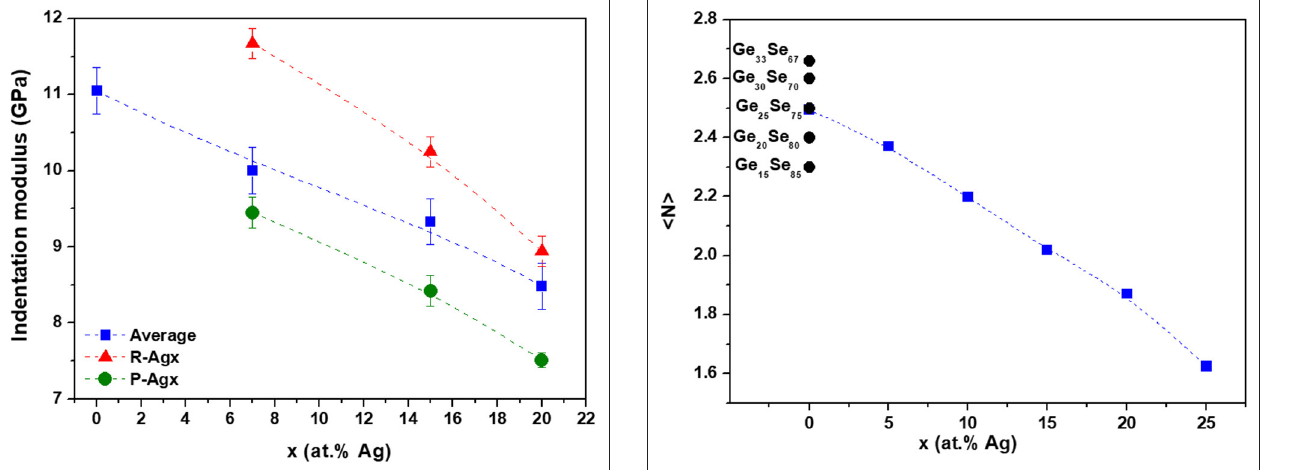
FIGURE 6 | Mean coordination number < N > for Ag x (Ge 0.25 Se 0.75 ) 100 − x glasses estimated using Zeidler et al. (2016). For comparison, mean coordination number < N > for Ge y Se 100 − y glasses are presented assuming < N Ge > = 4 and < N Se > = 2 for the mean coordination numbers of Ge and Se, respectively.